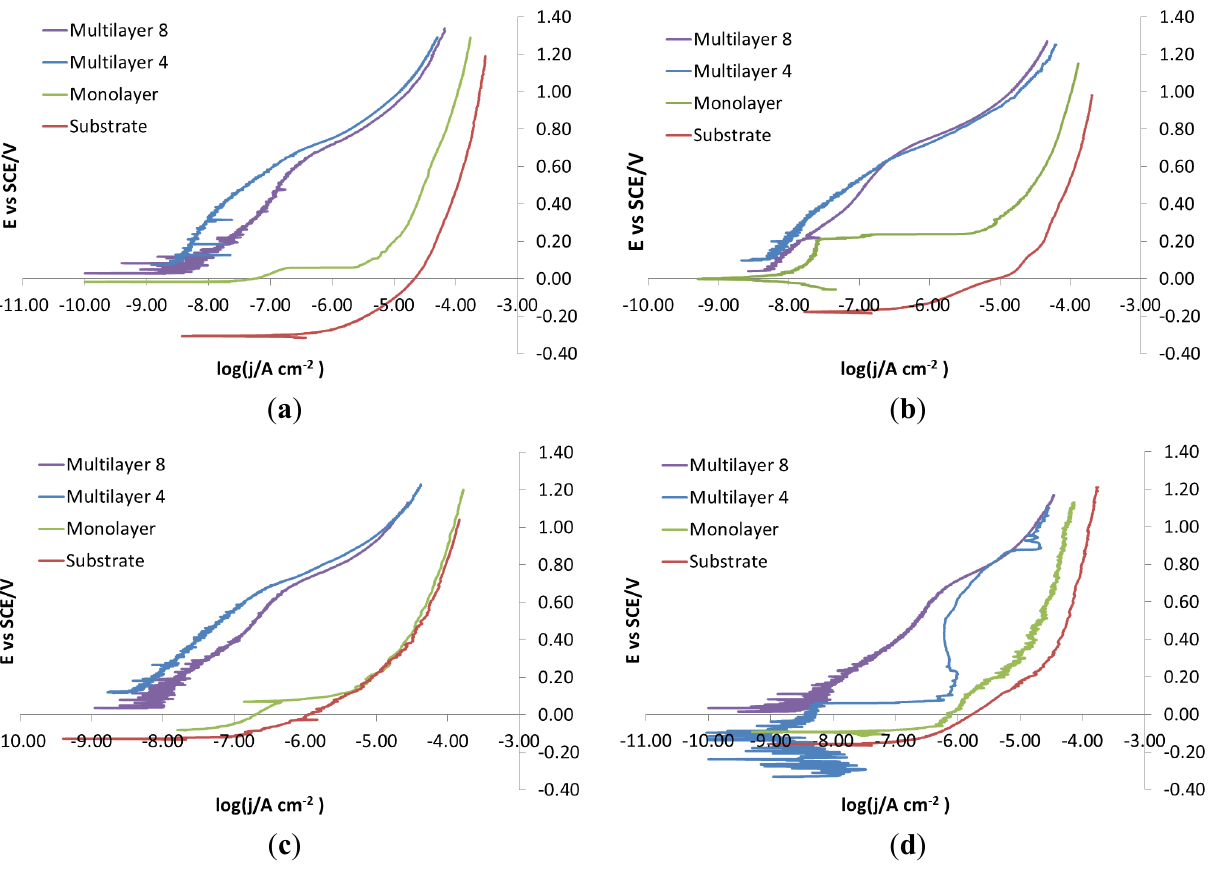
Figure 6. Mirror finish: polarization curves on bare and coated steels. ( a )